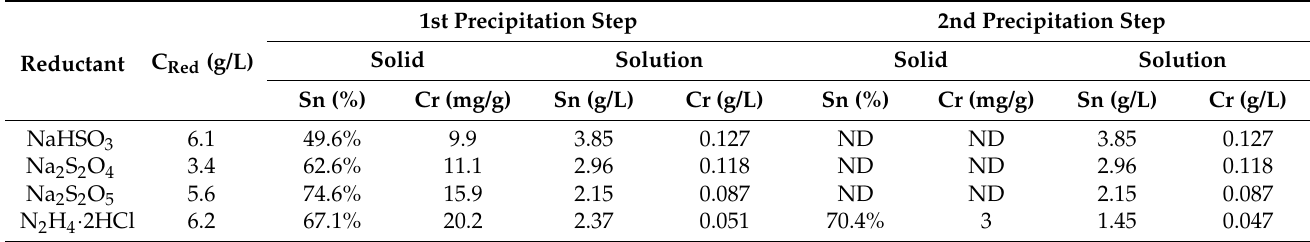
Table 7. Sn and Cr concentration in solutions and solids produced at reconstruction process in